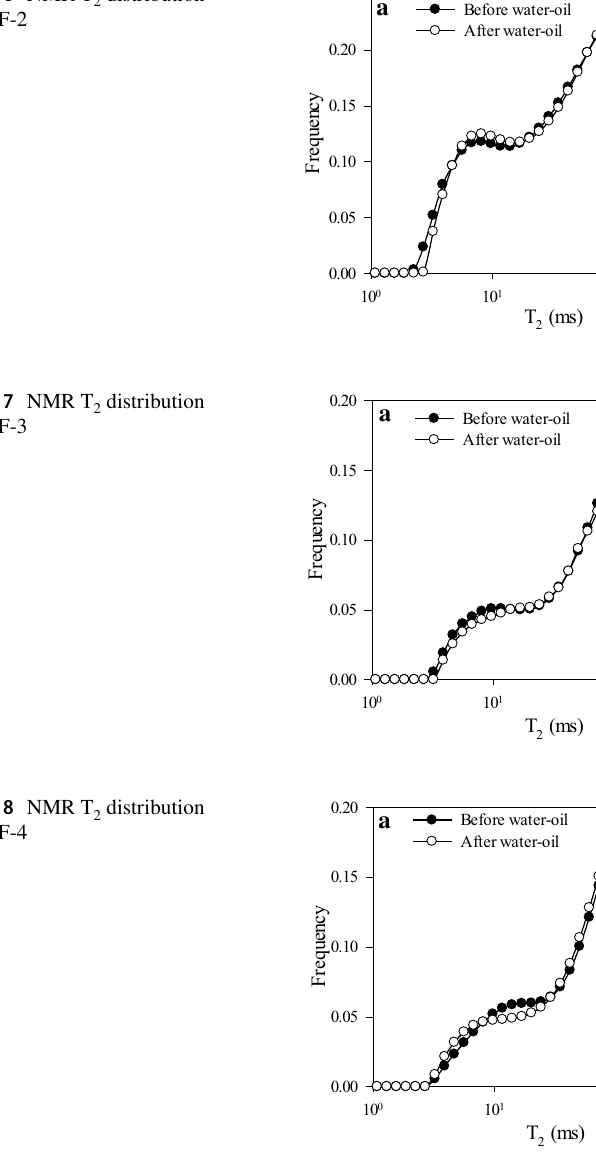
Fig. 6 NMR T for F-2